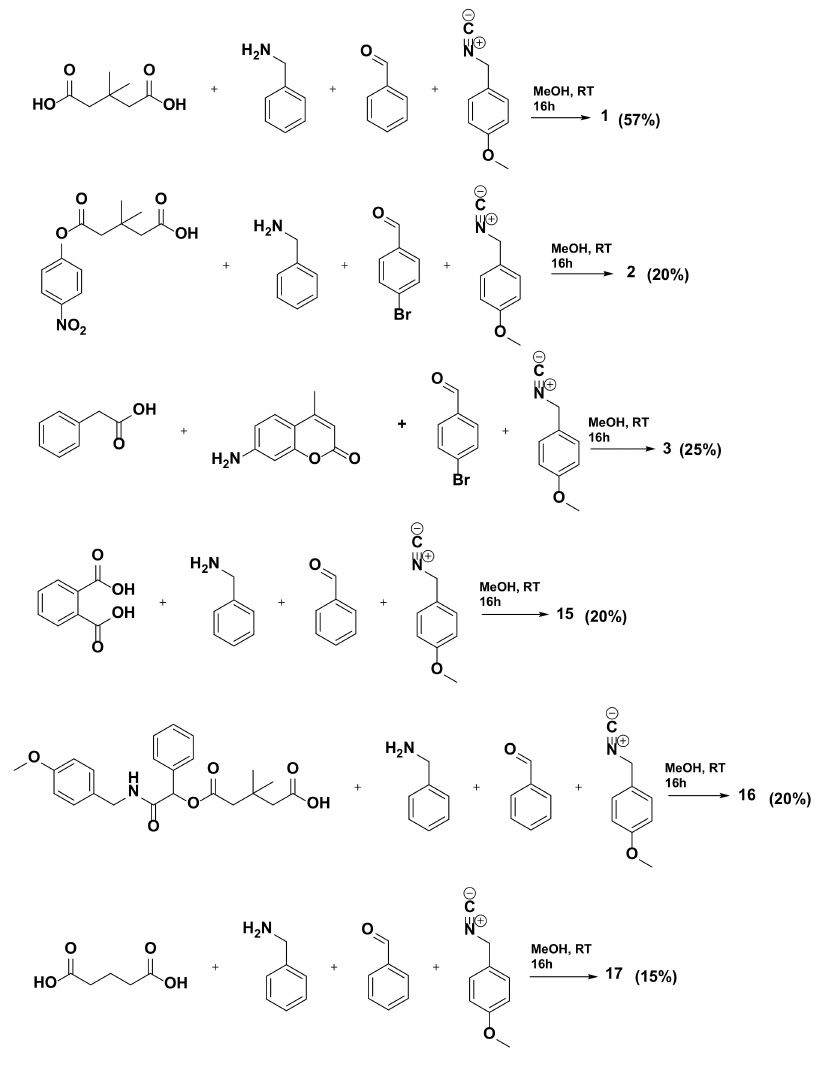
Scheme 1. Synthesis of compounds depicted in Figure 1.